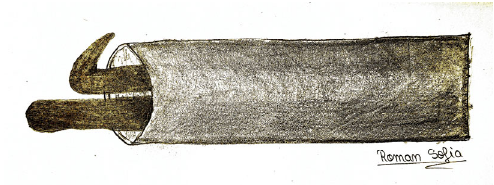
Figure 8. Guidewires impacted around the hook.